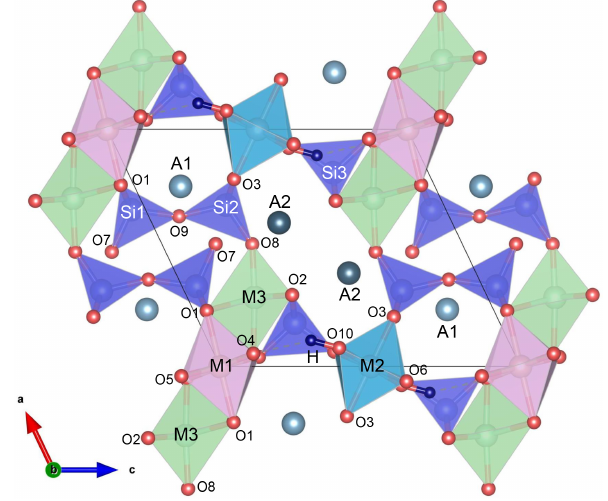
Figure 1. Epidote crystal structure projected along the b axis; the MO 6 octahedral volume increases in order M2 < M1 < M3; A1 and A2 are 9- and 10-coordinated, respectively; O10 is occupied by hy- droxyl groups, which are almost parallel to the c axis. The figure was prepared using VESTA 3 (Momma and Izumi,